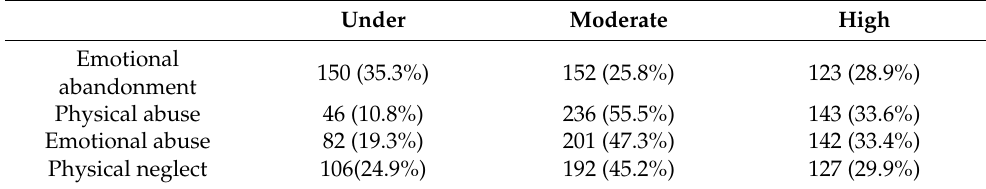
Table 5. Distribution of the sample according to the level and type of child abuse suffered. Under